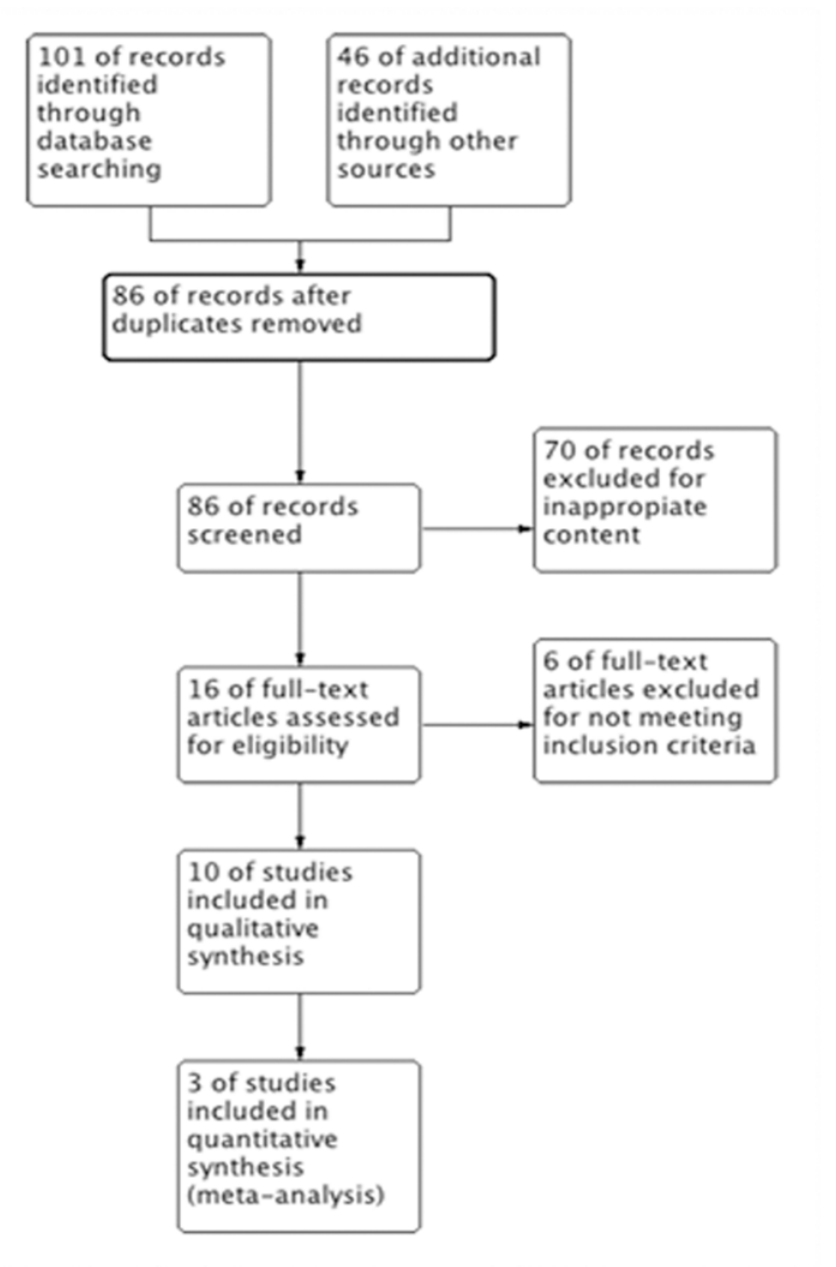
Fig 1. Flow chart of the study